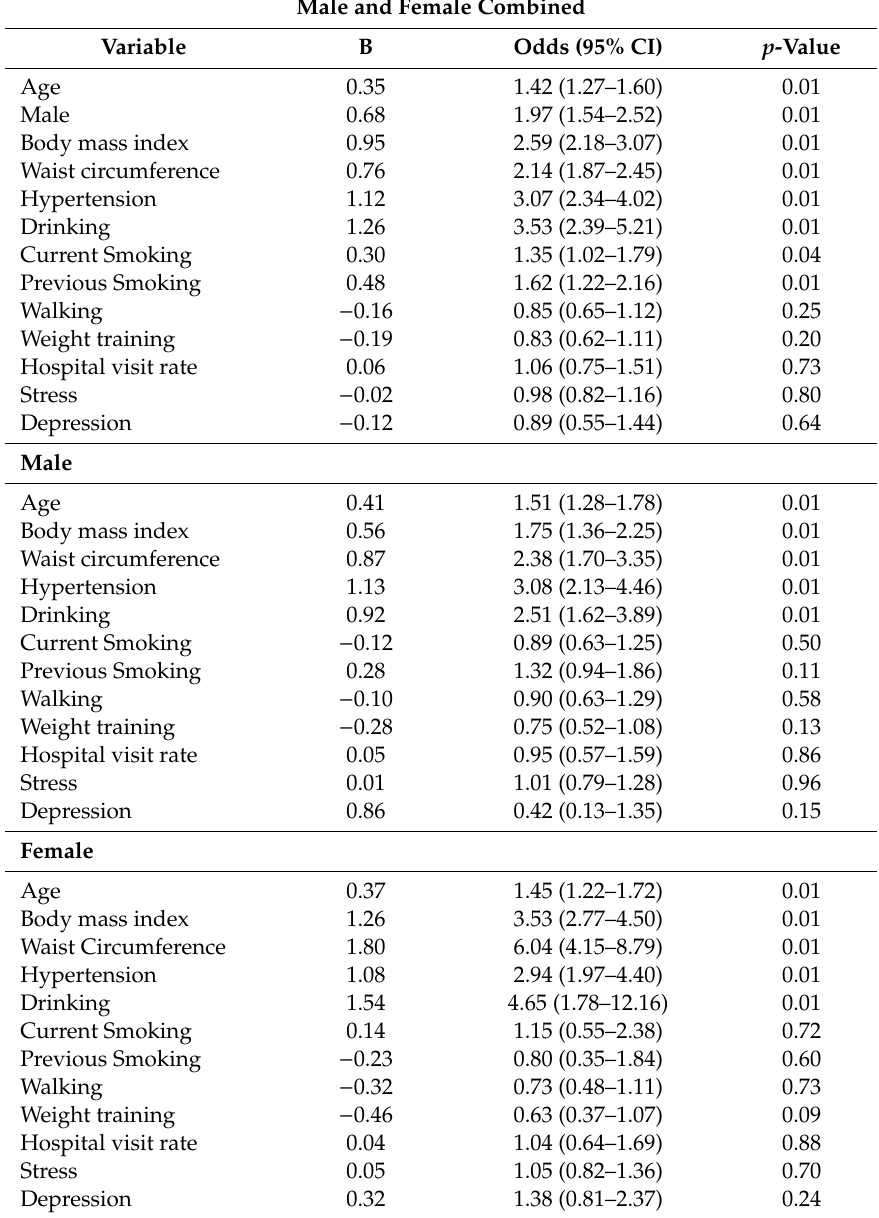
Table 2. Univariate Analysis of people with